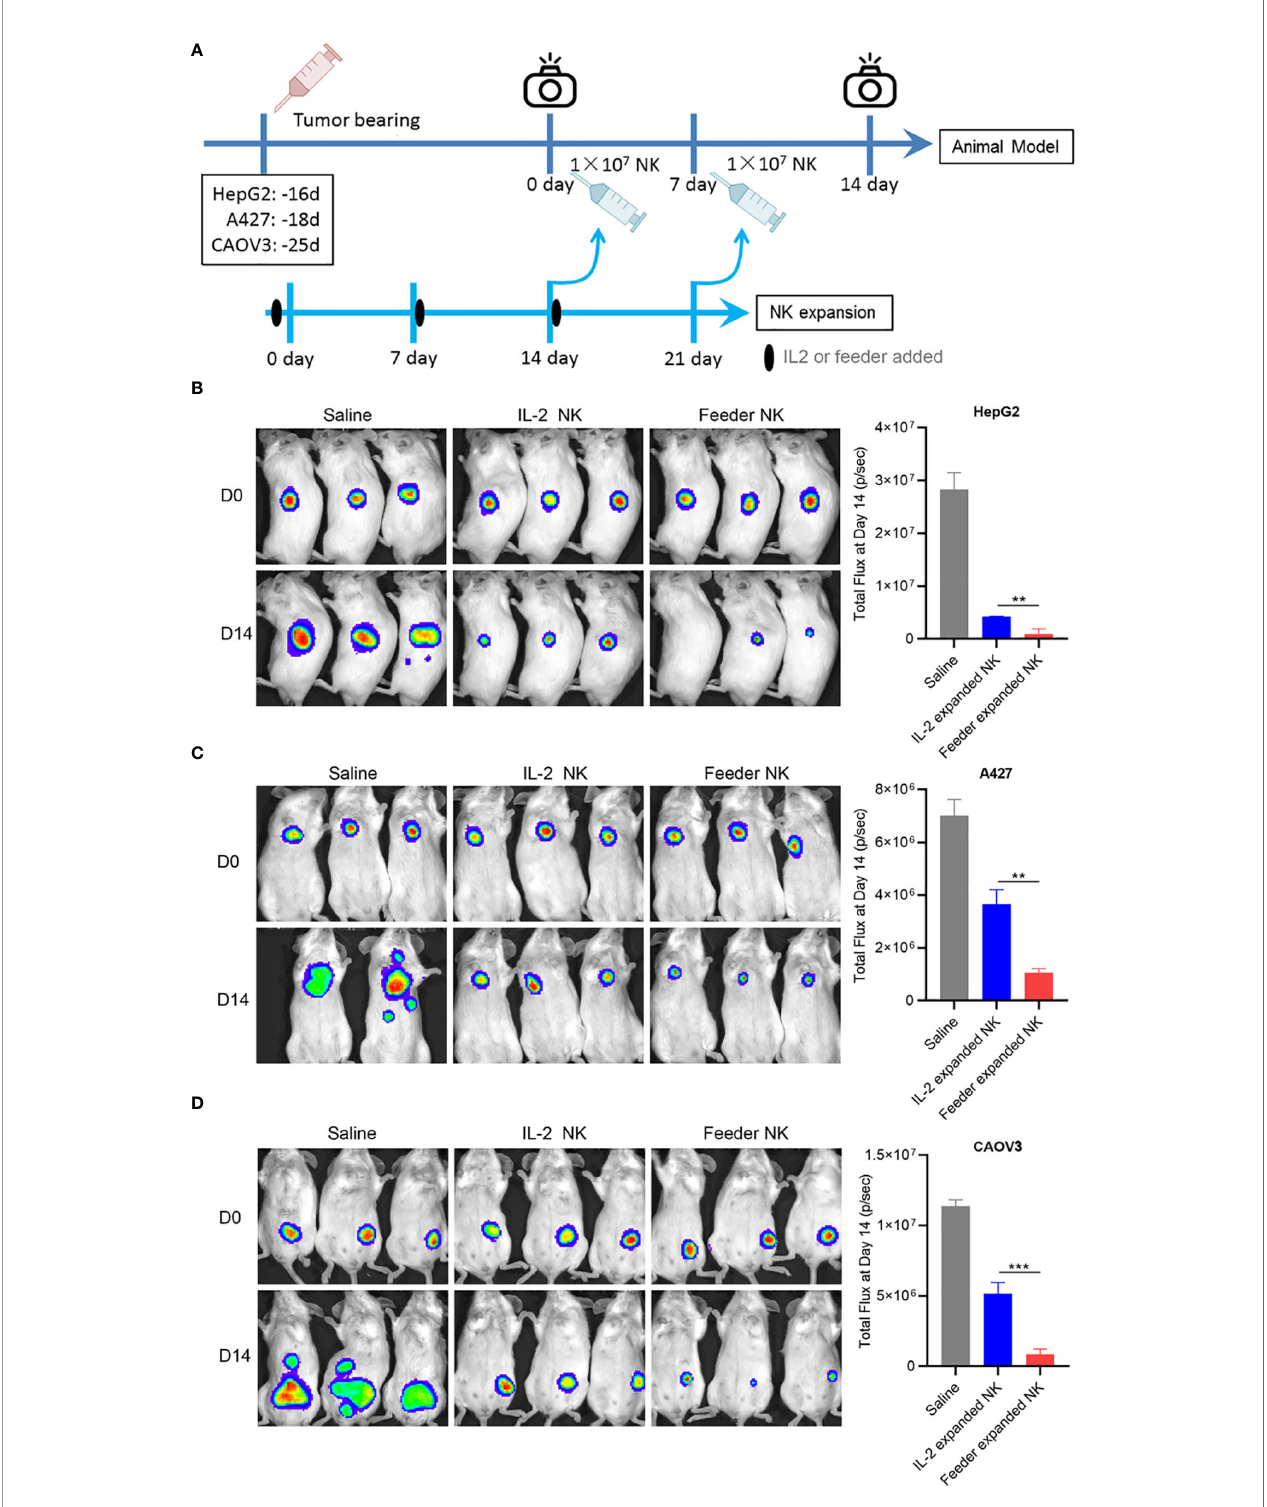
FIGURE 5 | NK92-Neo2/15-OX40L improves antitumor activity of NK cells in vivo (**p < 0.01, ***p < 0.001). (A) Experimental setup schematics. (B) NOD/SCID mice treated as in (A) , HepG2 tumors were visualized by IVIS SpectrumCT, and the tumor size was assessed by bioluminescence. (C) NOD/SCID mice treated as in (A) , A427 tumors were visualized by IVIS SpectrumCT, and the tumor size was assessed by bioluminescence. (D) NOD/SCID mice treated as in (A) , CAOV3 tumors were visualized by IVIS SpectrumCT, and the tumor size was assessed by